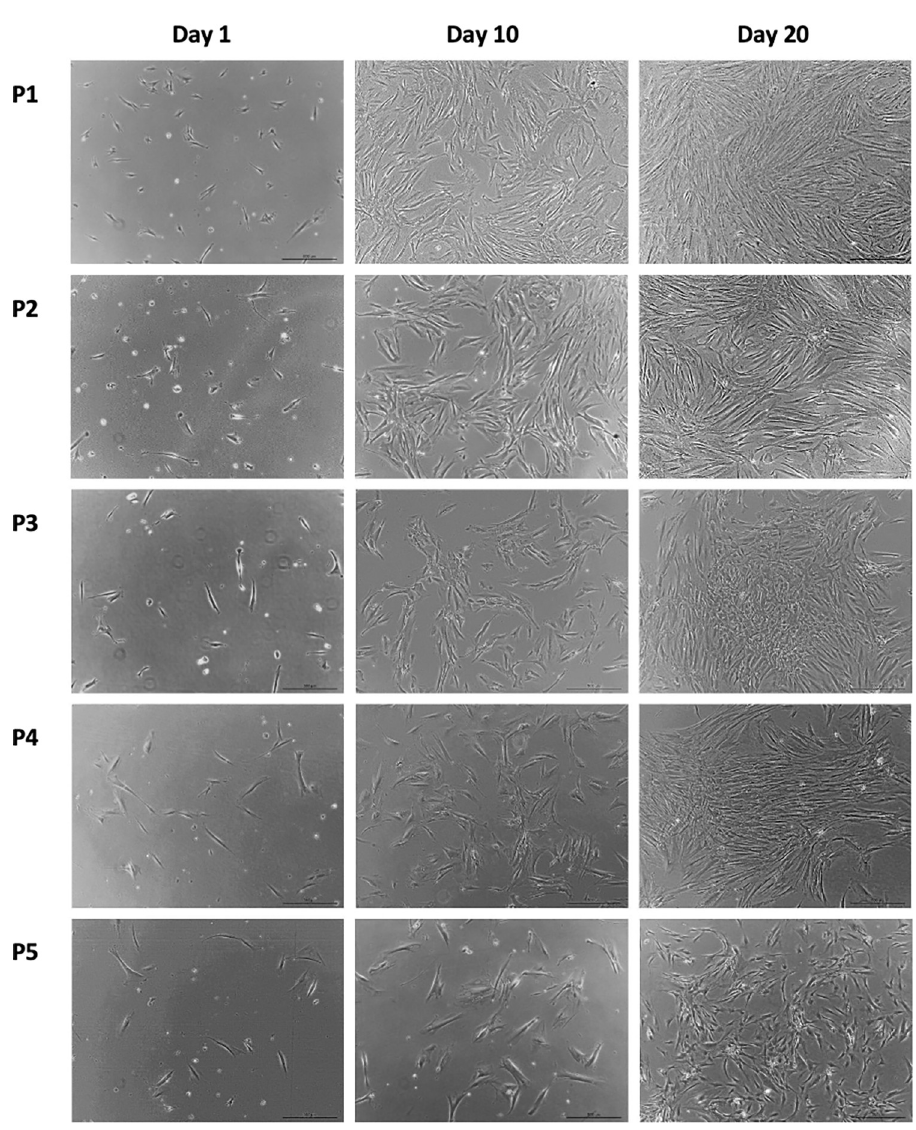
Fig 2. Photographs of cells from test sample on day 1, day 10, and day 20 for all 5 passages at 5x magnification (2 mm = 200 μ m).